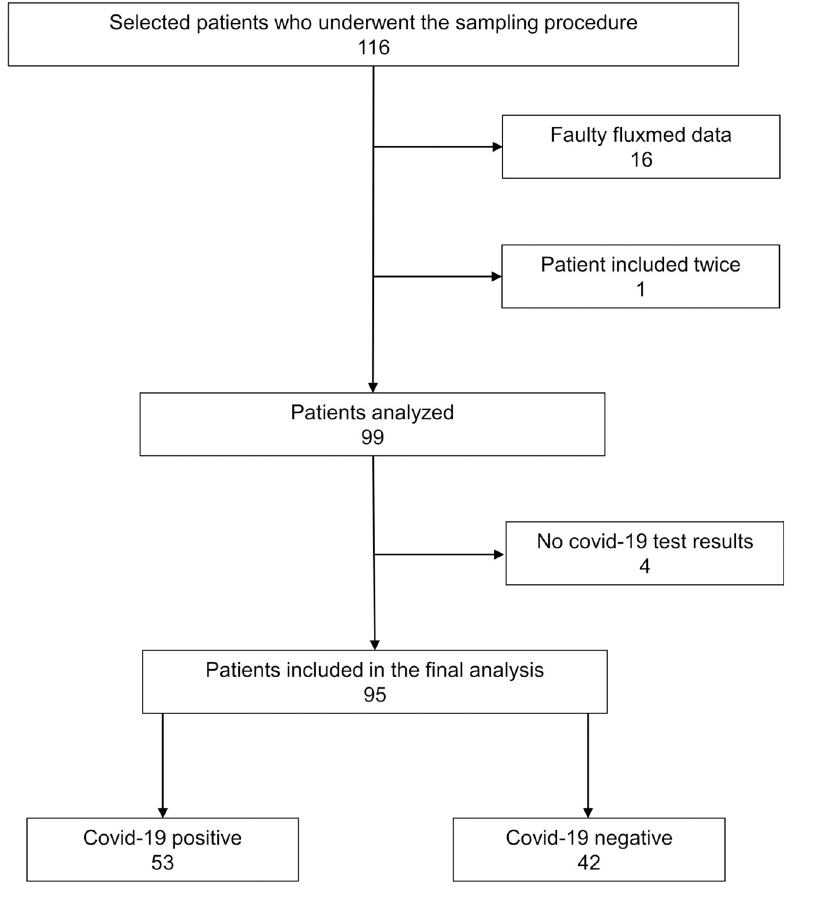
Fig 1. Inclusion